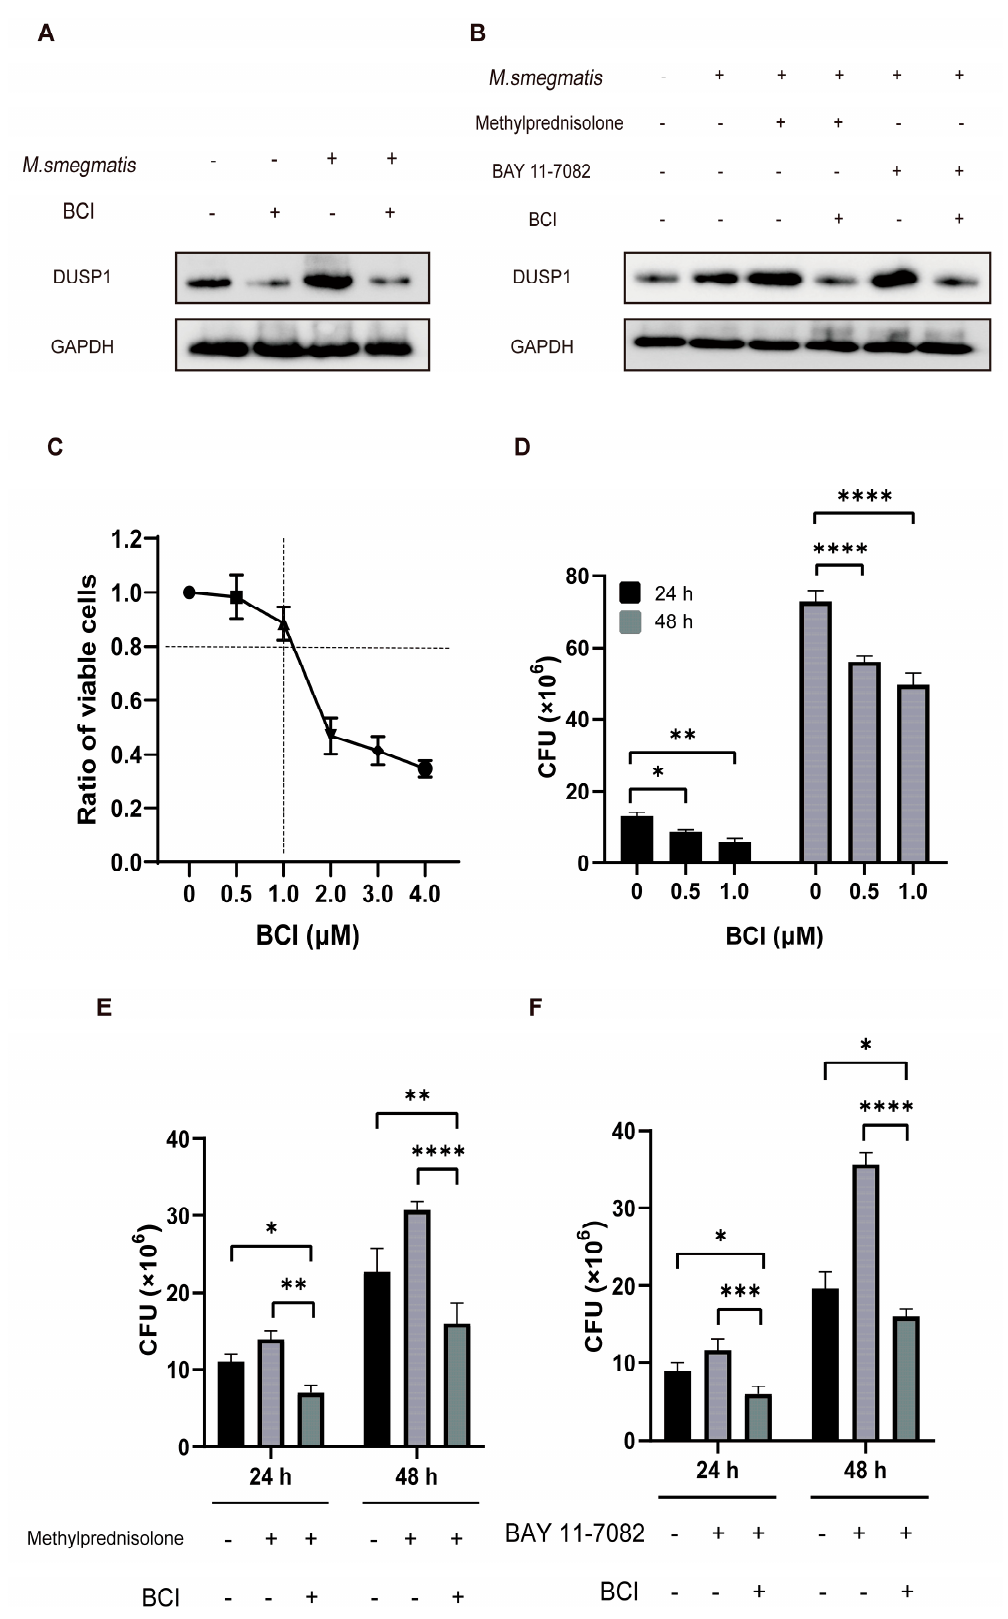
Figure 7. ( A ) After treatment of 48 h, DUSP1 levels were detected with Western blot analysis, cellular DUSP1 levels could be decreased by BCI (1 µ M) treatment, ( B ) and BCI (1 µ M) could reduce the